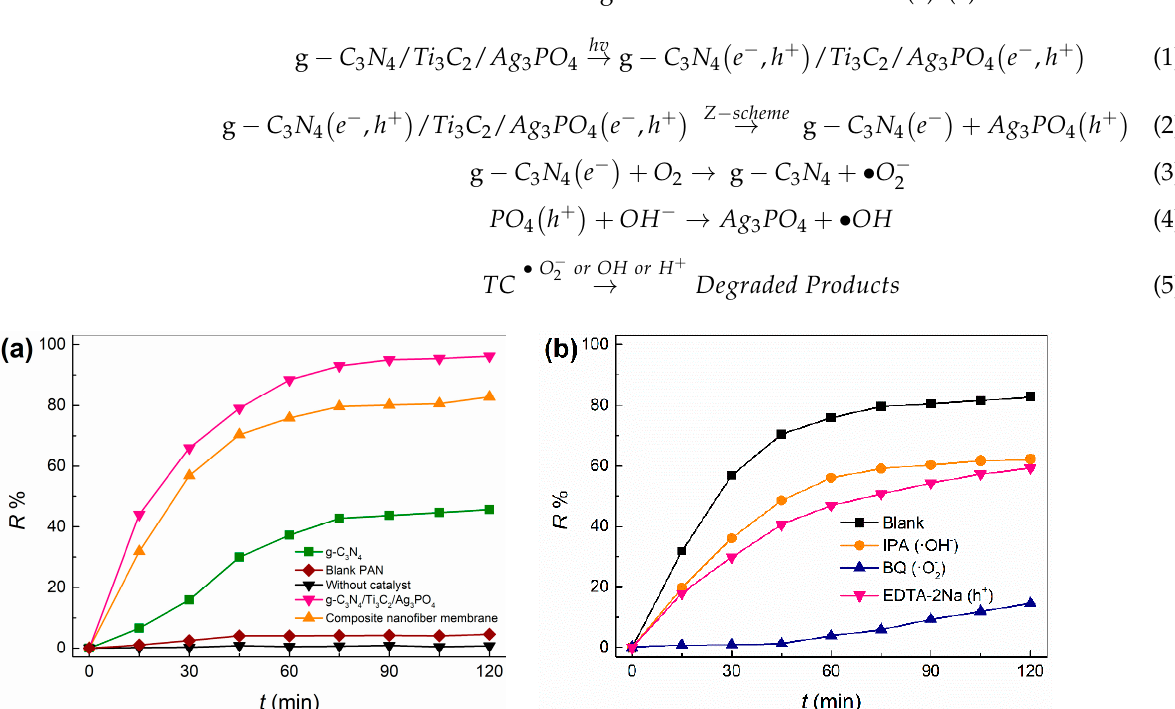
Figure 9. ( a ) Photocatalytic performance of catalyst, ( b ) Effect of catalyst free radical catcher on catalytic performance of nanofiber membrane.